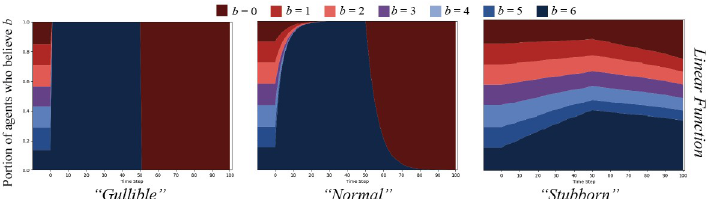
Fig 4. Linear cognitive contagion function result comparisons. The split message set on an ER random graph, N = 250, ρ = 0.05, for agents updating their beliefs based on the inverse linear cognitive contagion function in Eq (5). Graphs display percent of agents who believe B with strength b over time. The left graph shows agents parameterized to be “gullible” ( γ = 1, α = 0); the middle shows “normal” agents ( γ = 1, α = 1), and the right, “stubborn” agents ( γ = 10, α = 20).